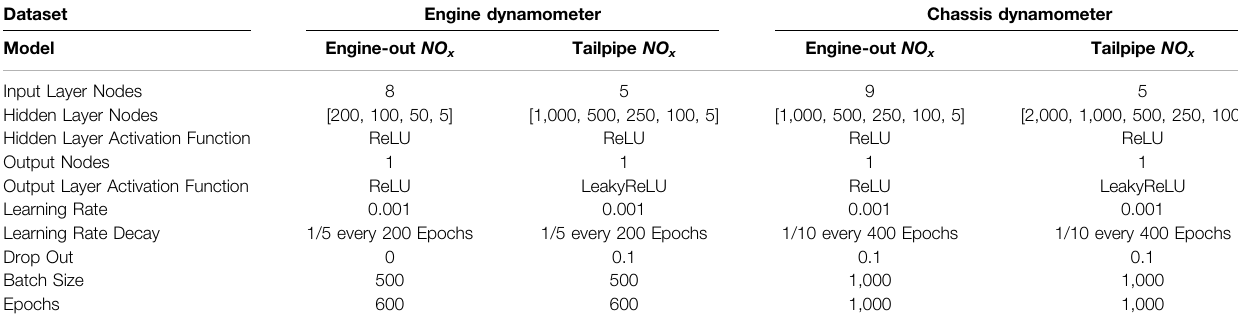
TABLE 3 | Final optimal hyperparameters for engine-out and tailpipe NO x models for dataset 1 and